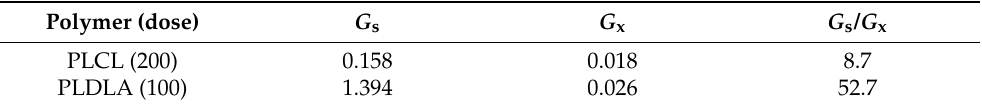
Table 2. Chain scission ( G s ) and crosslinking ( G x ) radiation yields of PLCL and PLDLA irradiated. Polymer